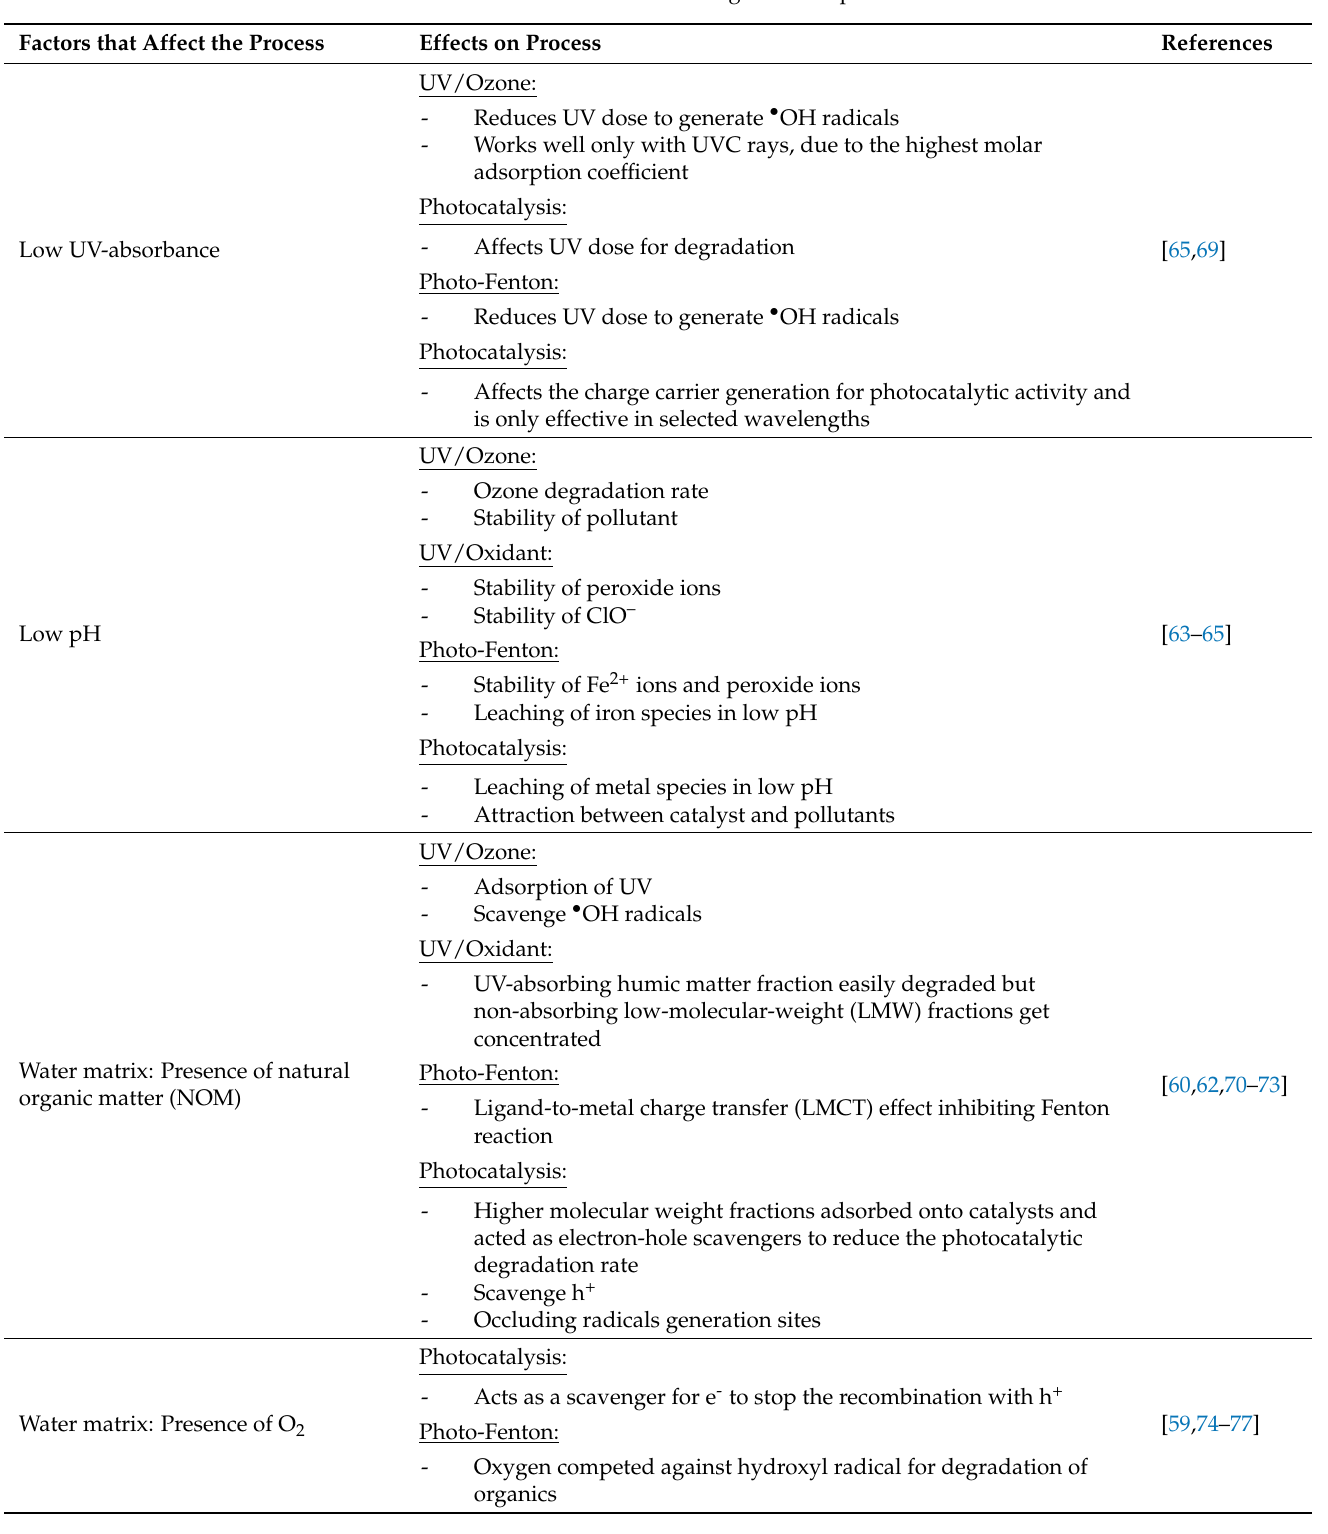
Table 3. Critical factors that affect light-driven